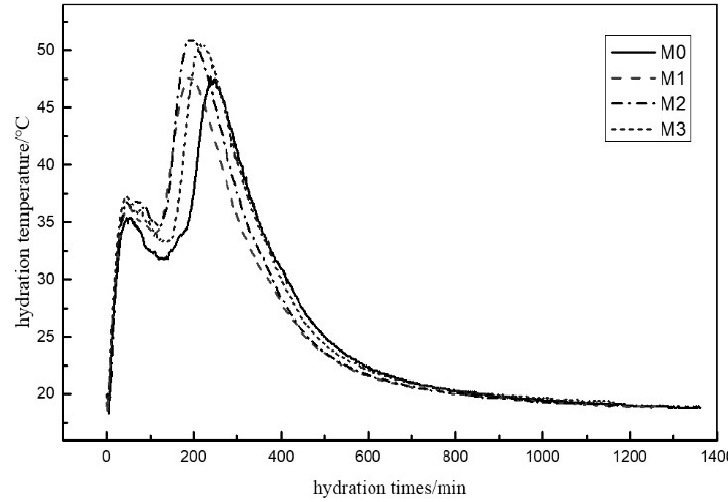
Figure 3. Hydration temperature of MKPC mortar with mineral admixture.